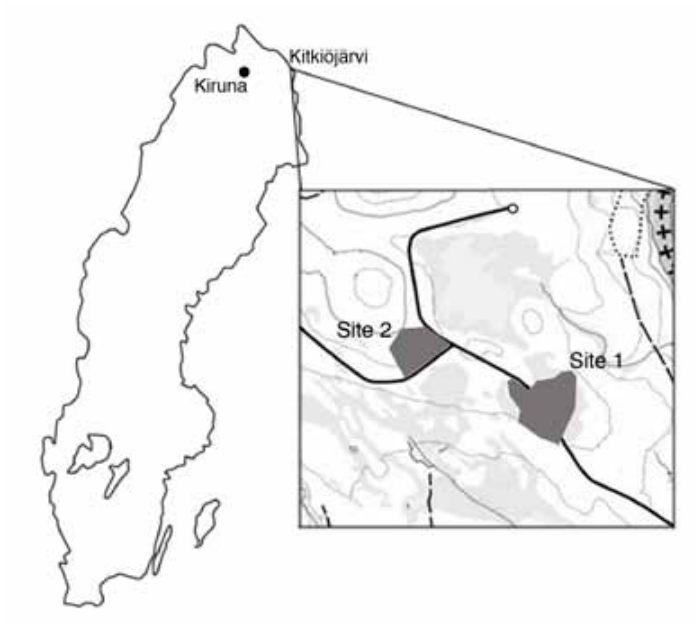
Fig. 1. Location of the experimental sites in the area of Kitkiöjärvi (67°49’N, 23°09’E), in northern